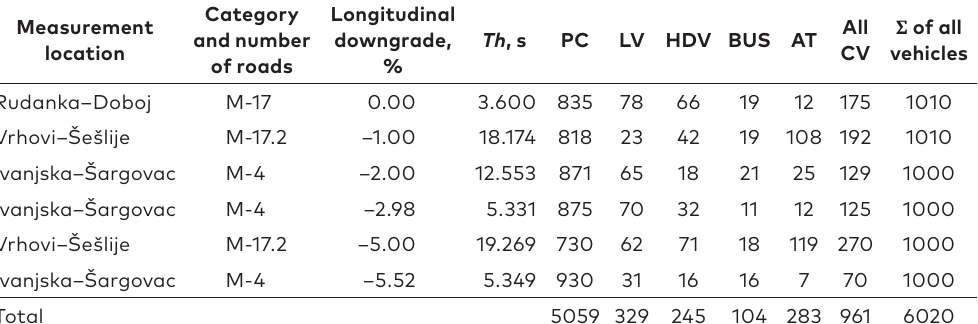
Table 5. Time headways and recorded number of vehicles at measurement locations grouped by